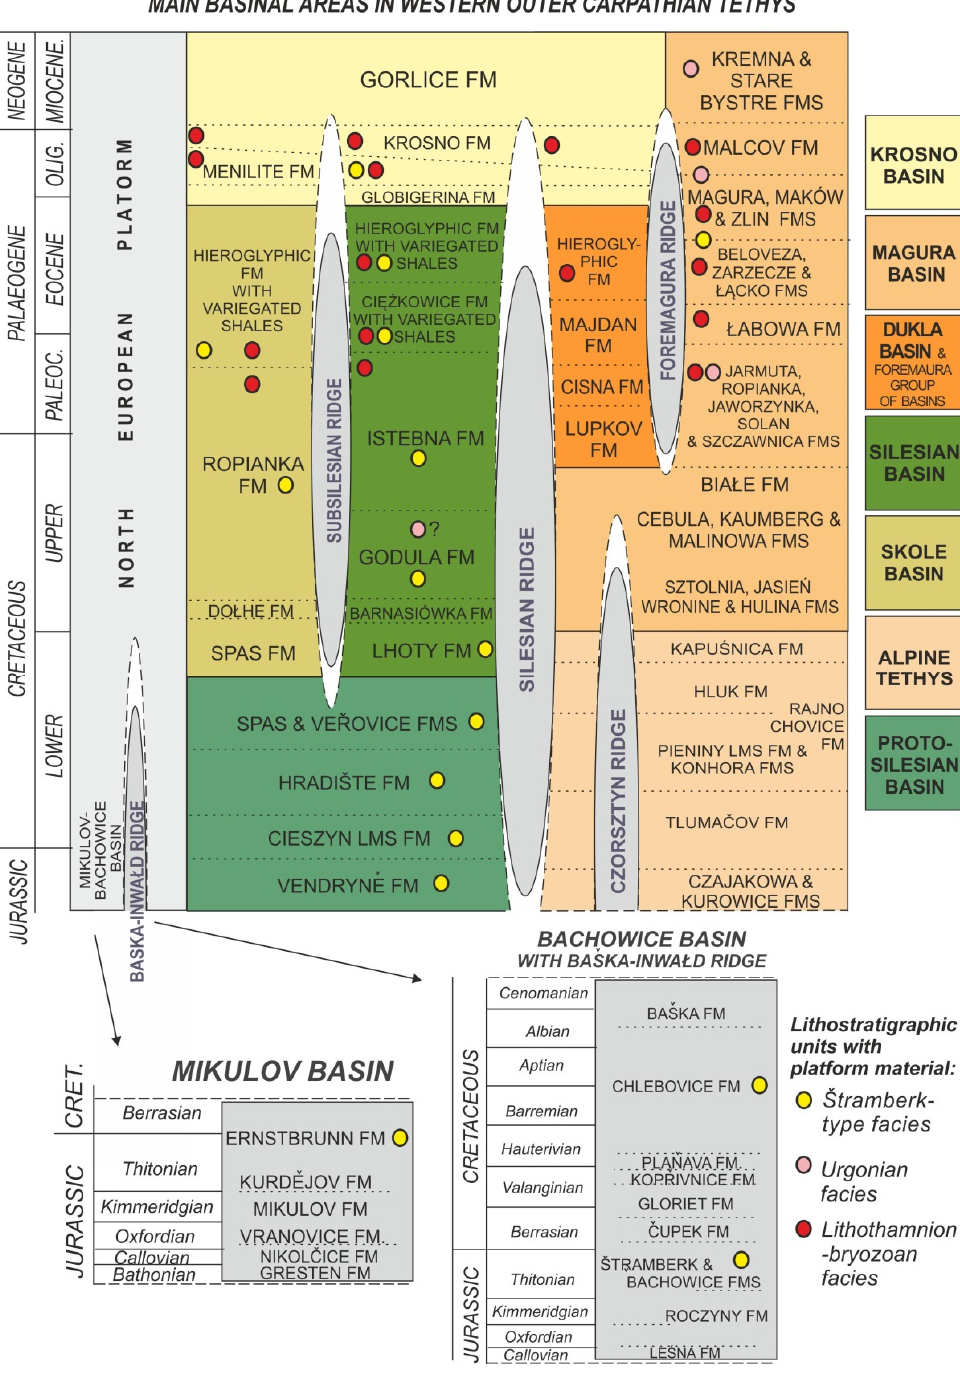
Figure 2. Main basinal lithostratigraphic units with platform material in the Outer Western Carpathians (based on [9]). ?—presumable (poorly documented) occurrence.